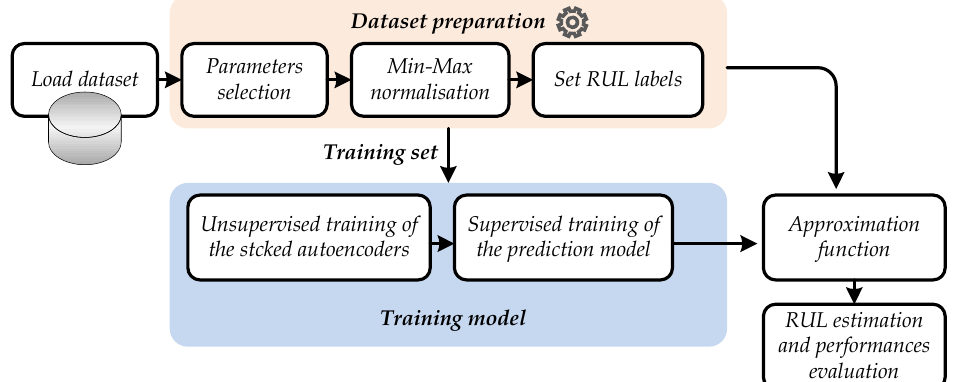
Figure 2. Flowchart of the proposed RUL prediction approach.